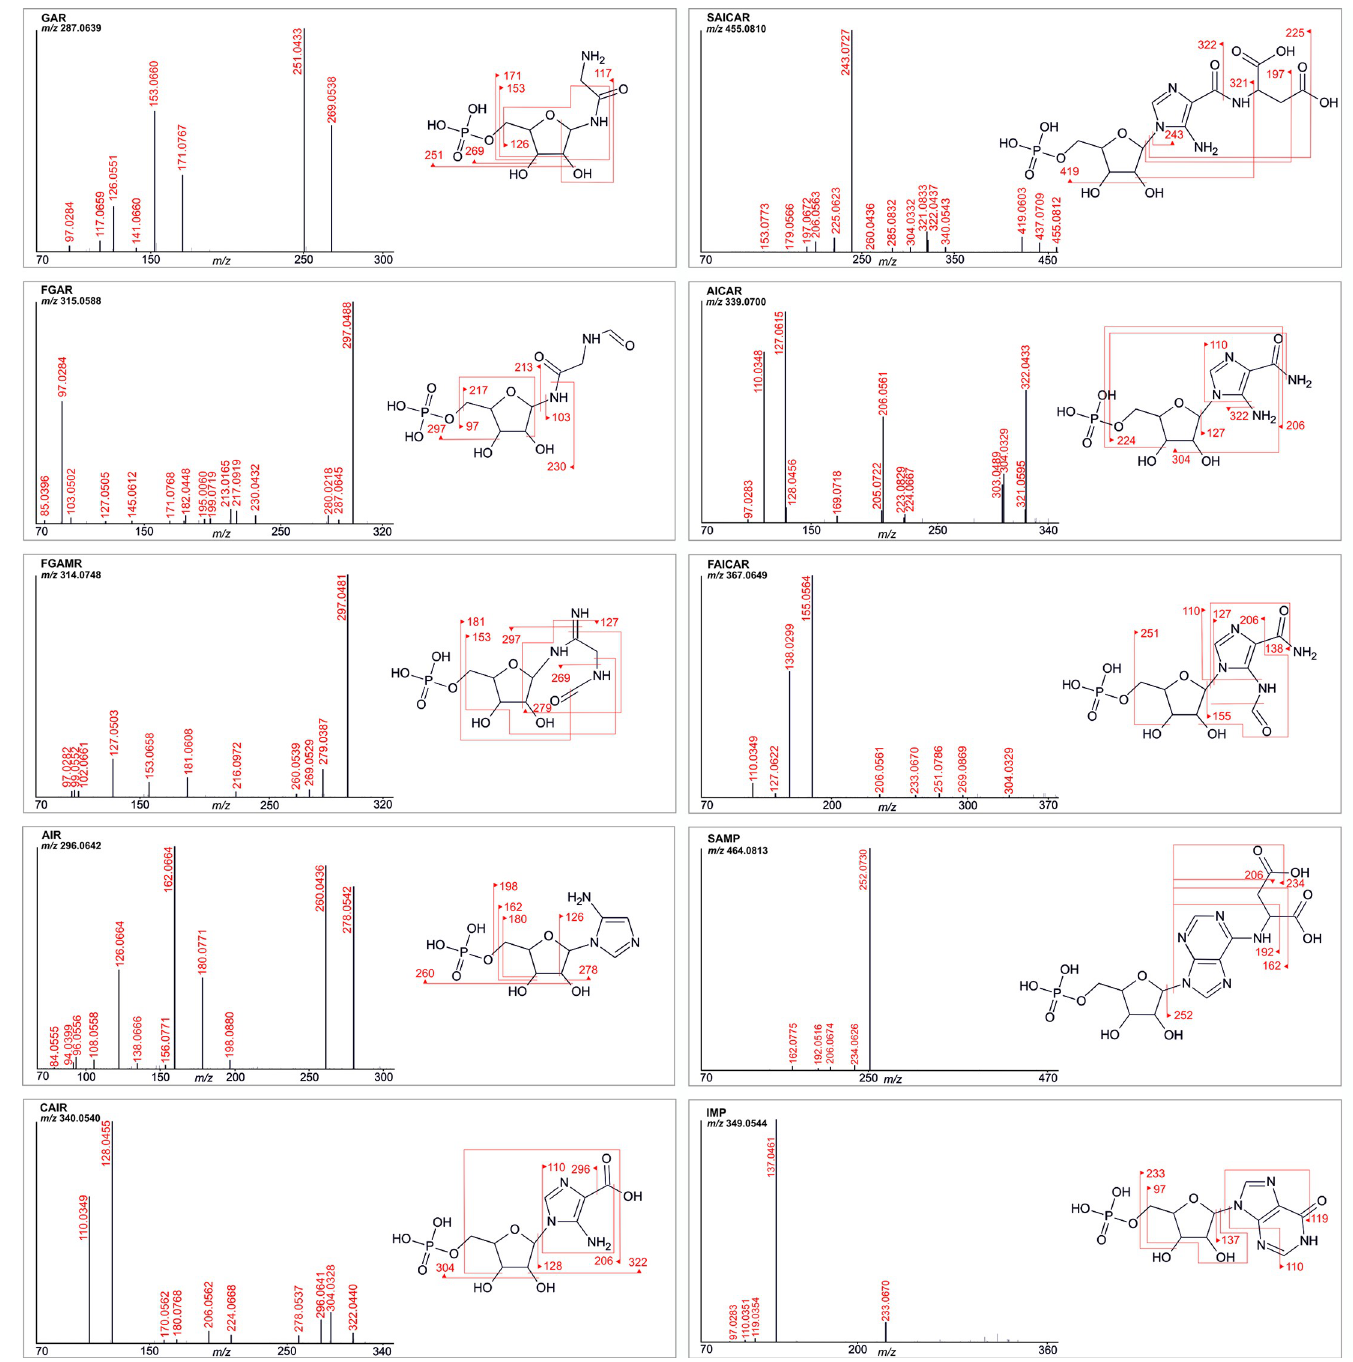
Fig 3. MS 2 fragmentation spectra of PDNS ribotides. The structure of the fragmented compound is shown next to every spectrum, and up to six of the most intense fragments are depicted in the